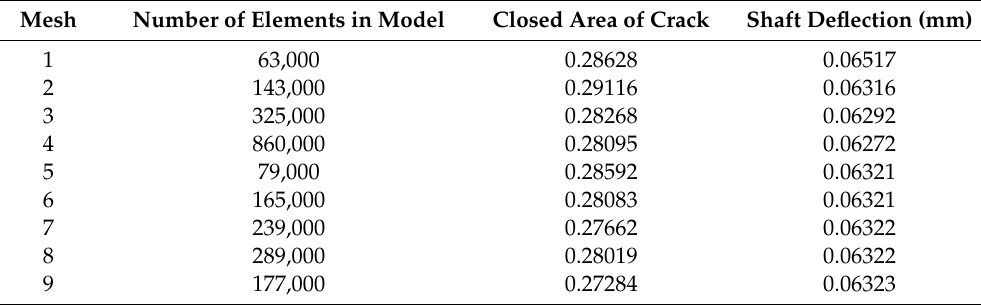
Table 1. Results of convergence test for various meshes.